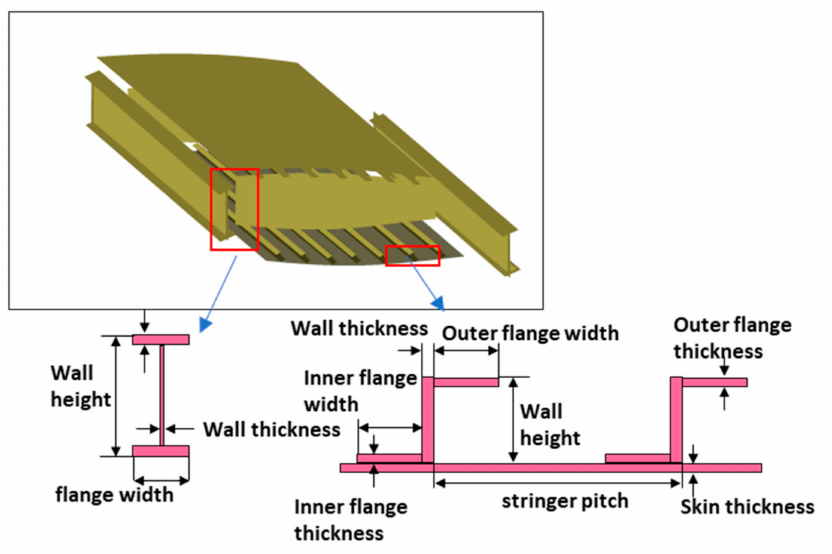
Figure 8. Parameters of the fourth level.